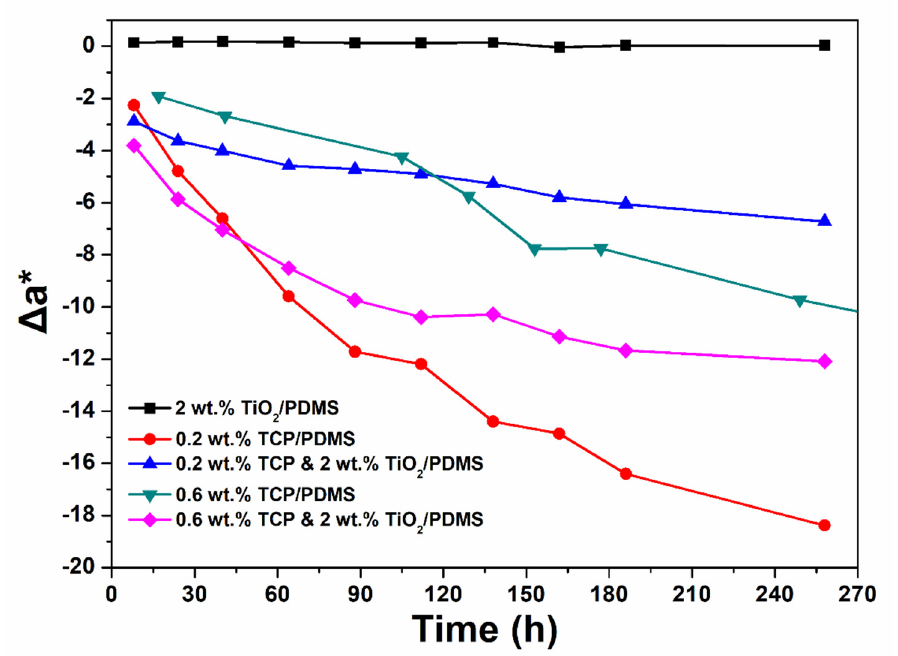
Figure 7. The red-green character Δ a* as a function of time, during accelerated aging of silicone elastomers colored with TCP (0.2 and 0.6 wt%).